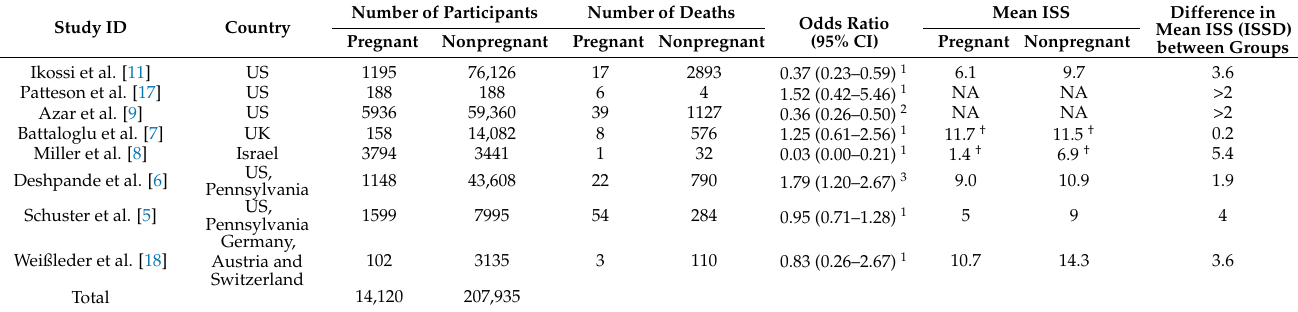
Table 2. Characteristics of studies included